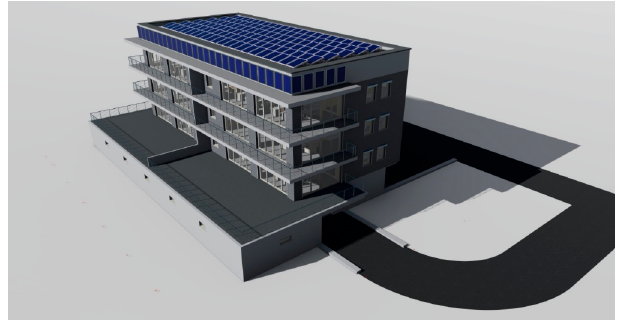
Figure 9. Model 2 of the building.